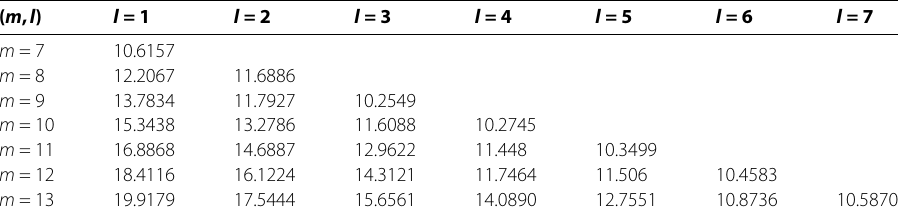
Table 1 Decay rates β m , l , α 1 ≤ l < m – 5, and α =